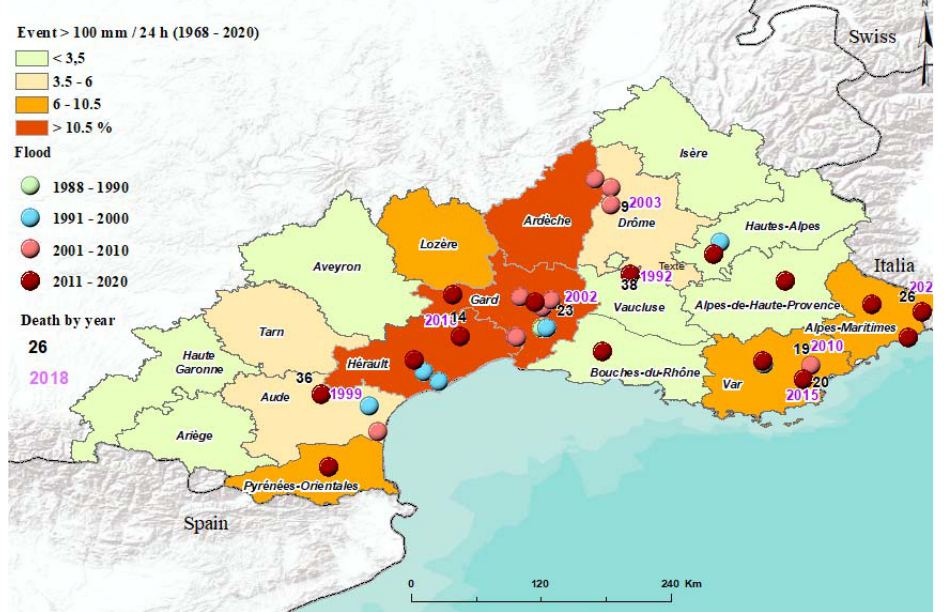
Figure 2. Heavy rainfall and floods in the French Mediterranean area. Data source: http://pluiesextremes.meteo.fr/france ‐ metropole/ ‐ Evenements ‐ memorables ‐ .html (accessed on 15 March 2022). http://floodobservatory.colorado.edu/Archives/index.html (accessed on 22 March 2022).